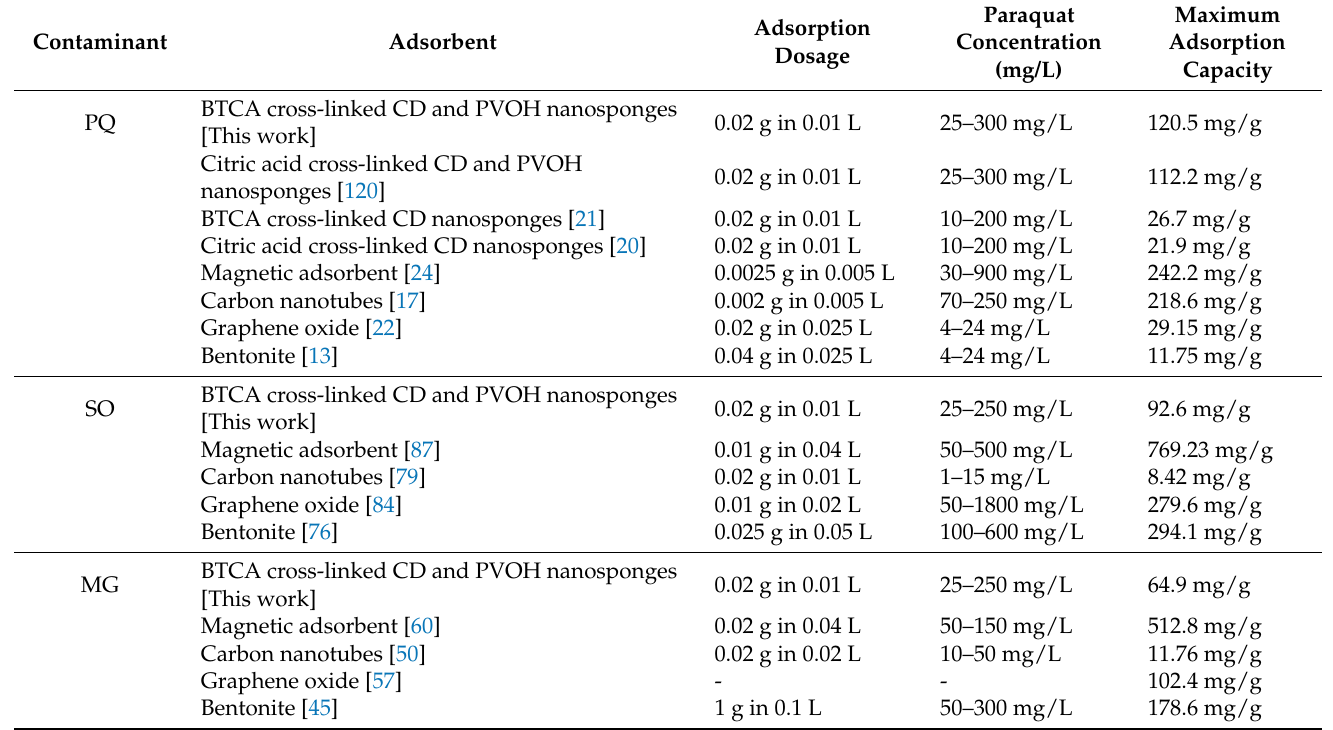
Table 4. Langmuir isotherm for contaminant removal by various adsorbents.